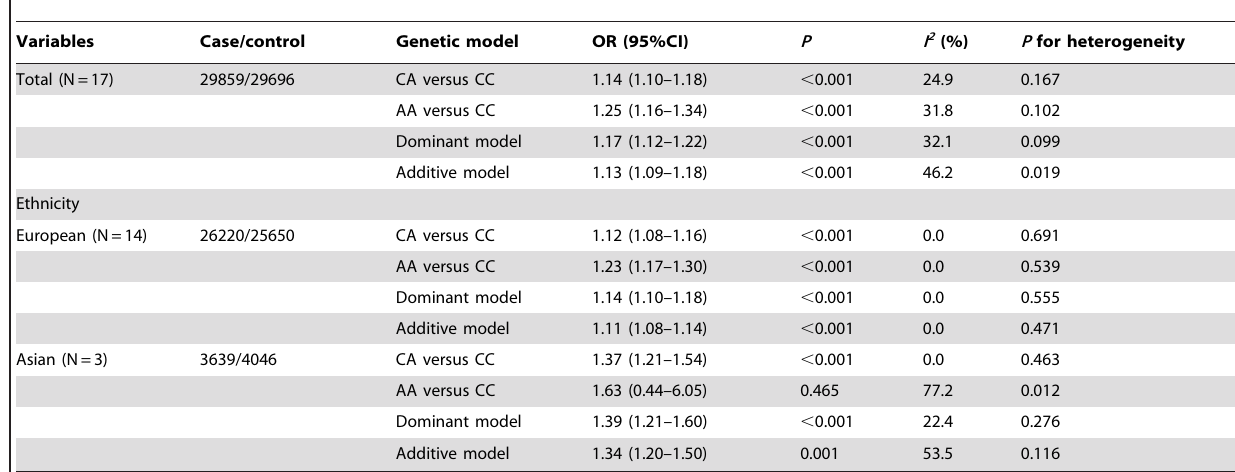
Table 3. Meta-analysis of the rs961253 in association with colorectal cancer risk under different genetic models.